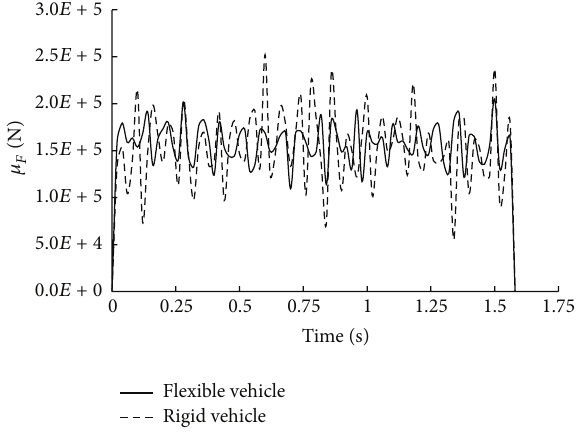
Figure 20: Mean of imposed force time history of the bridge due to passage of rigid and flexible vehicle.